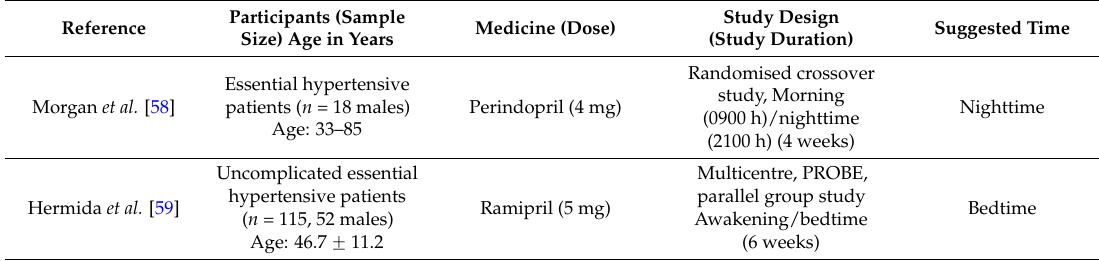
Table 3. Evidence supporting the chronotherapy of antihypertensive